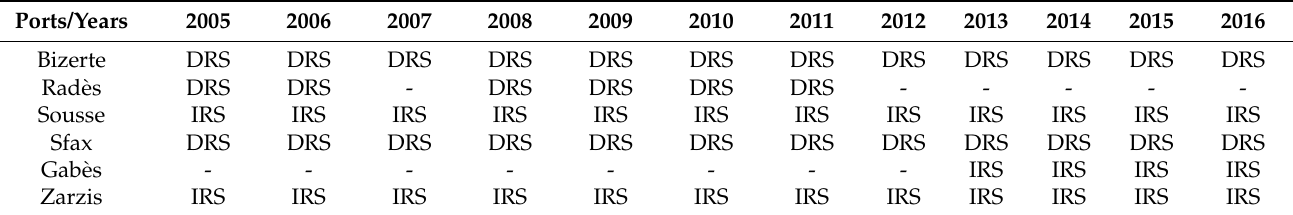
Table 7. Types of returns to scale of the selected ports.